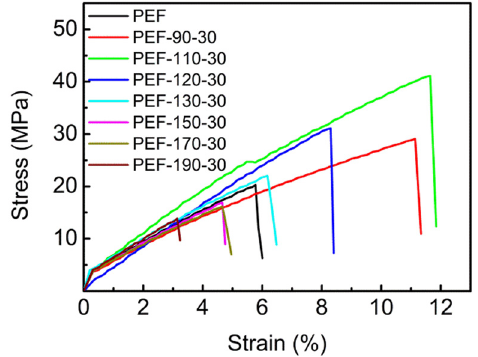
Figure 2: DSC heating curves of PEF - T - 30. Figure 3: Tensile stress – strain curves of PEF - T -